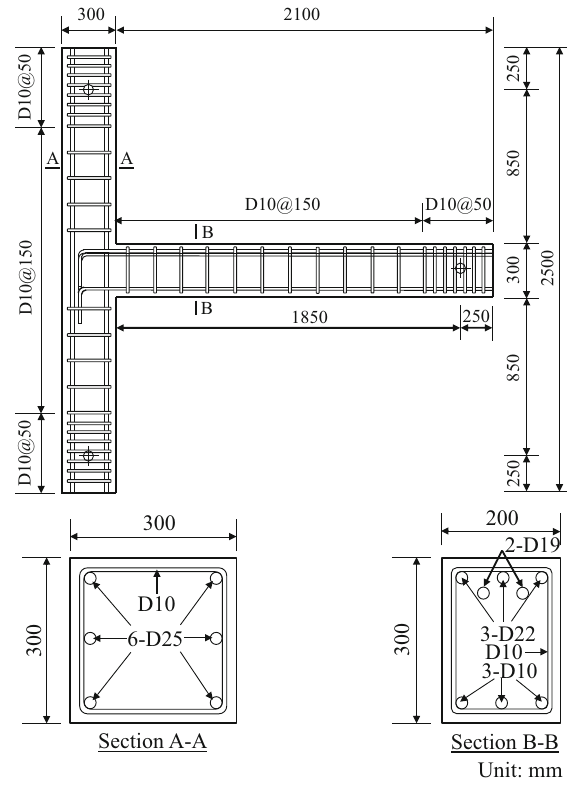
Fig. 2 Details of control specimen